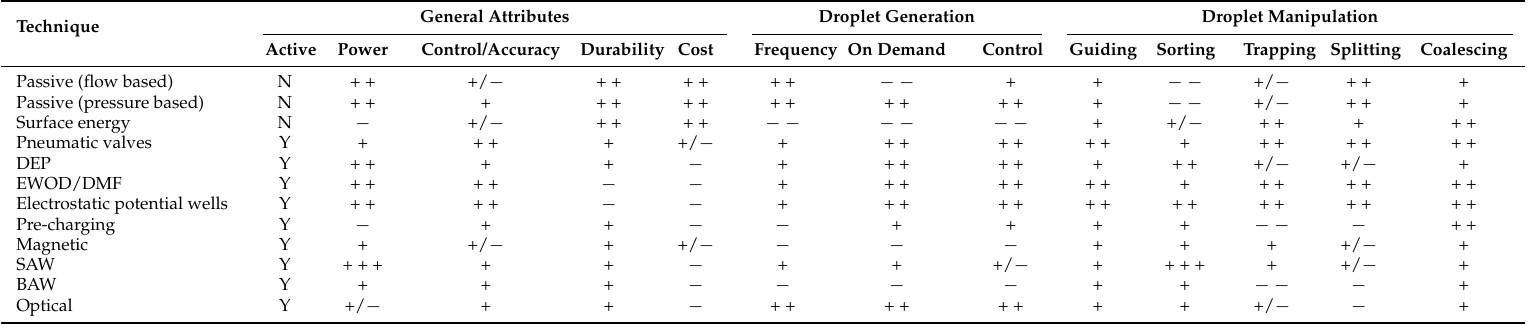
Table 1. Overview of the techniques discussed in this review and their